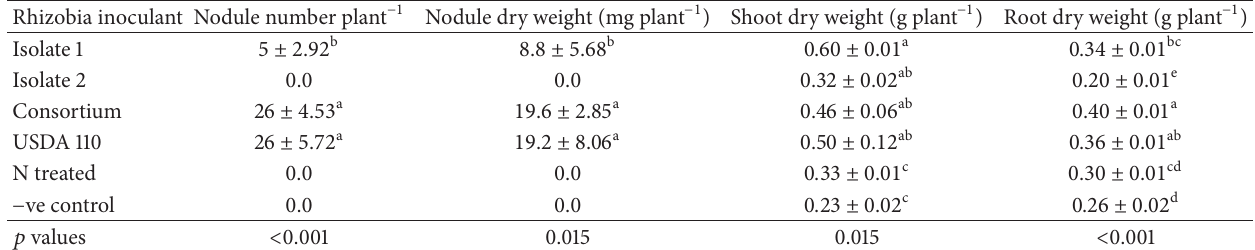
Table 3: Soybean growth parameters and nodulation as affected by rhizobia